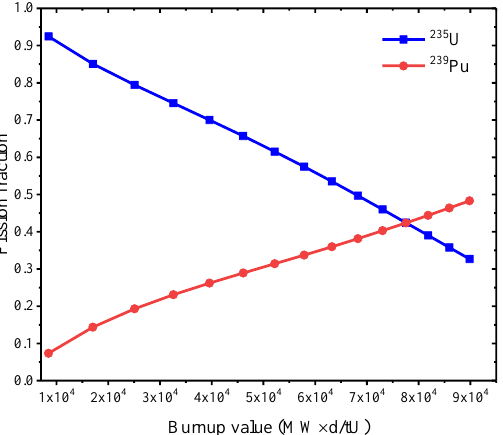
Figure 5. Fission fraction of 235 U and 239 Pu during burnup